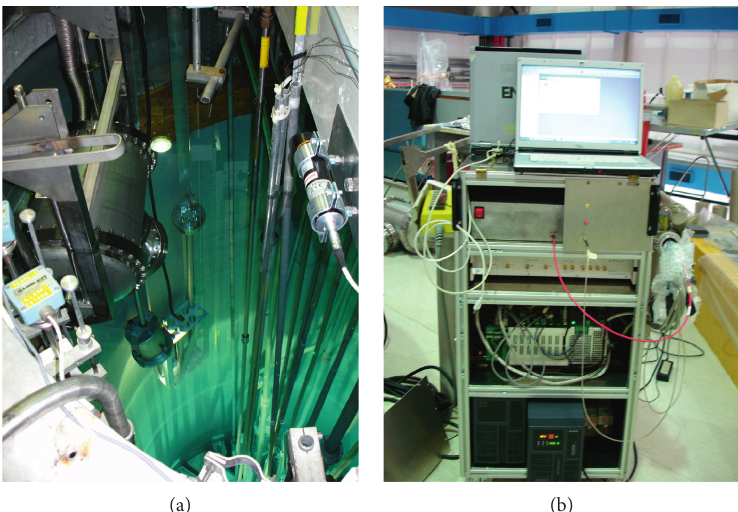
Figure 5: (a) Passive module immersed in the TRIGA RC1 RV. (b) The active module during system installation at TRIGA RC1.